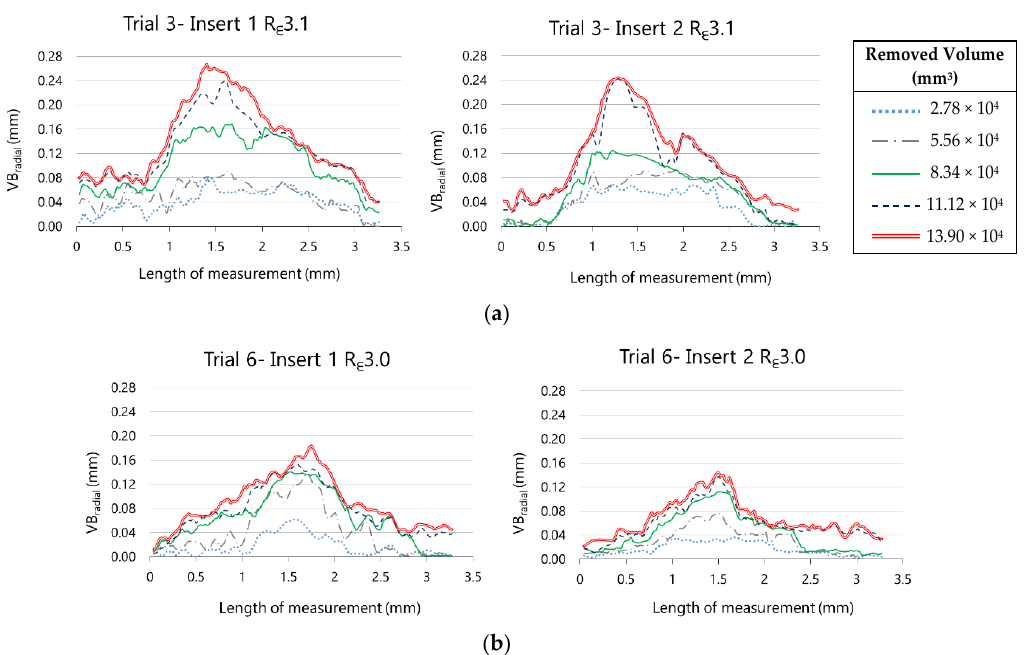
Figure 19. Evolution of the radial flank along the cutting edge on ( a ) R ᗴ 3.1 inserts and ( b ) R ᗴ 3.0 inserts.